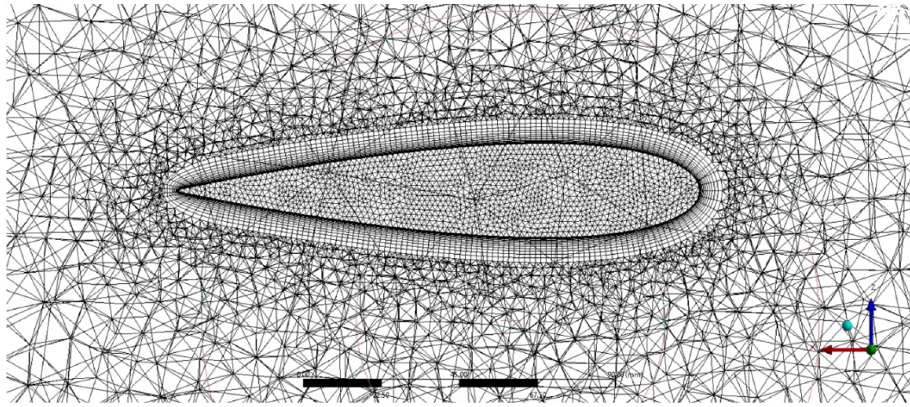
Figure 4. Sectional view of mesh around the blade surface in the rotor domain.